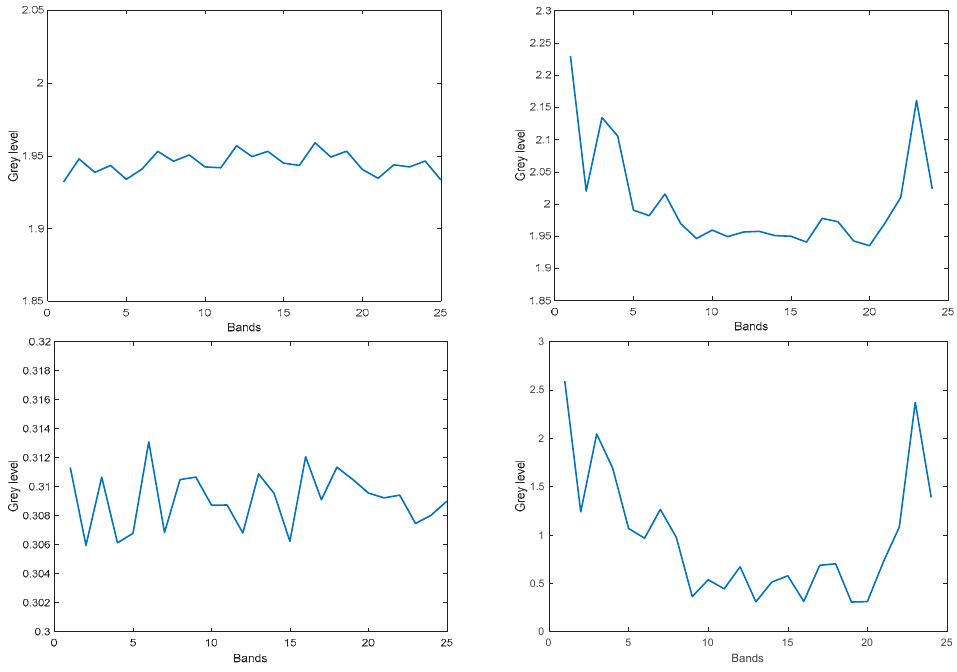
Figure 3. Dark current: Mean dark current for the original 25 bands ( top left ) and 24 virtual bands ( top right ). Dark noise variance for the original 25 bands ( bottom left ) and 24 virtual bands ( bottom right ).